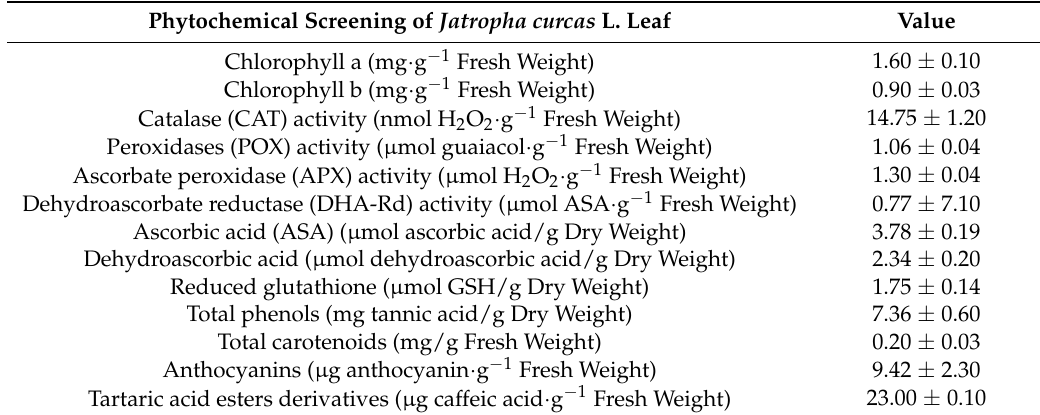
Table 2. Analysis of phytochemical composition and enzymatic antioxidants of leaves of Jatropha curcas L. Value were expressed as mean ± standard error ( n =